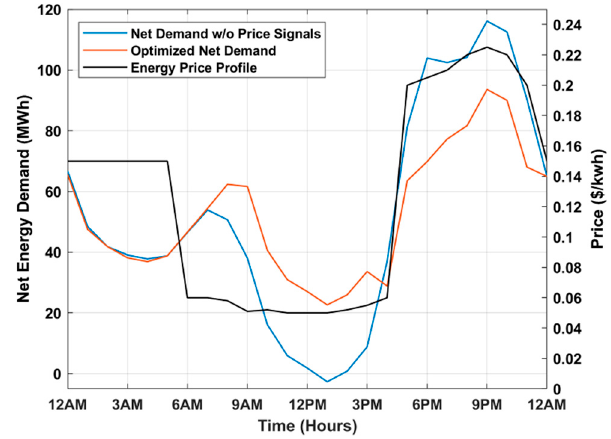
Figure 7. Net demand with no price signals vs. optimized net demand with price signals.